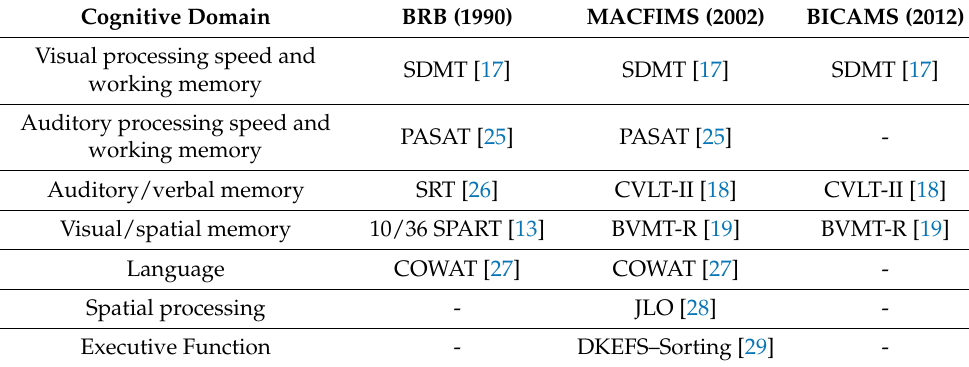
Table 1. The neuropsychological tests and corresponding cognitive domains measured by the Brief Repeatable Battery (BRB) [13], Minimal Assessment of Cognitive Function in Multiple Sclerosis (MACFIMS) [14], and the Brief International Cognitive Assessment for Multiple Sclerosis (BICAMS) [16]. In parenthesis next to each neuropsychological battery is the year in which it was